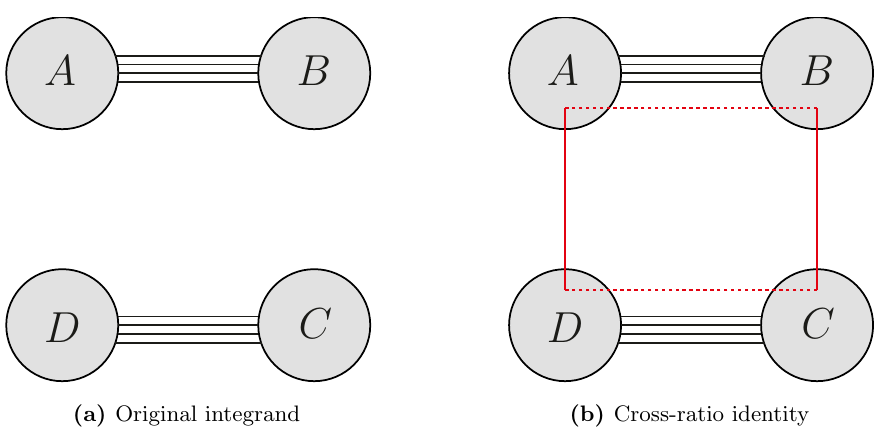
Figure 2. Con(cid:12)guration of the original integrand and the cross-ratio identity of the rule II. Four red lines represent the term z jn z 1 i provided by the cross-ratio z ij z 1 n